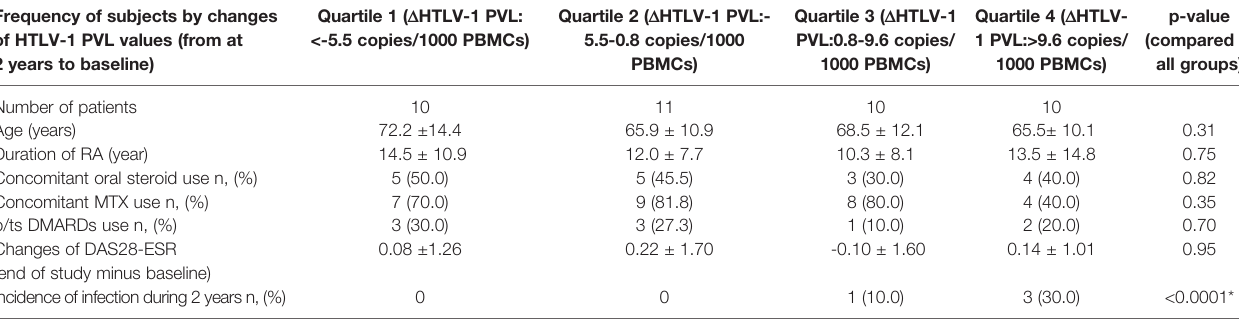
TABLE 3 | Comparison of baseline variables and clinical course by changes of HTLV-1 PVL values. Frequency of subjects by changes of HTLV-1 PVL values (from at 2 years to baseline)